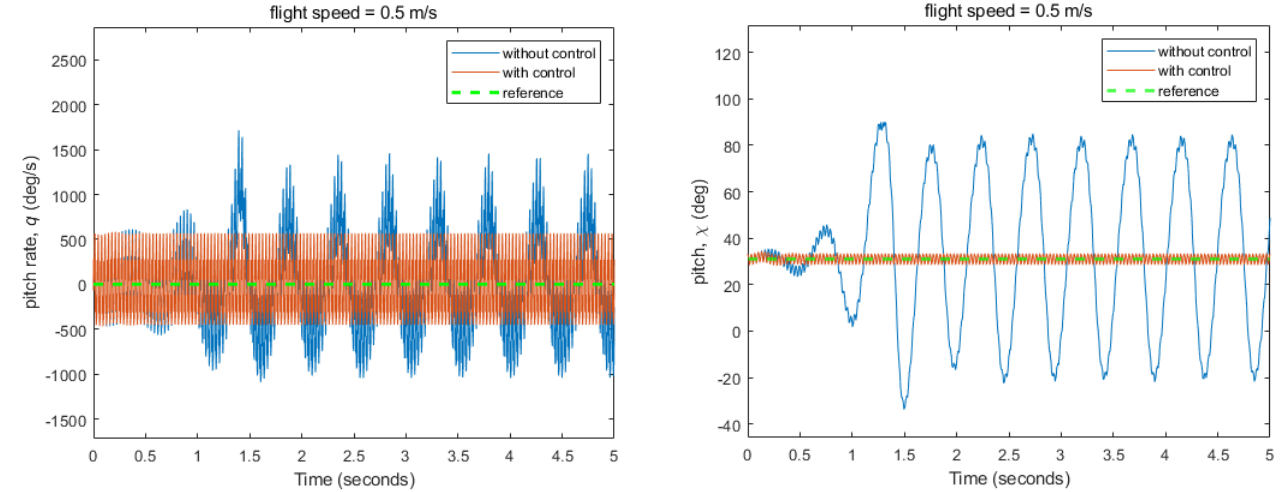
Figure 17. Flight control simulations for forward flight control (flight speed = 0.5 m/s).